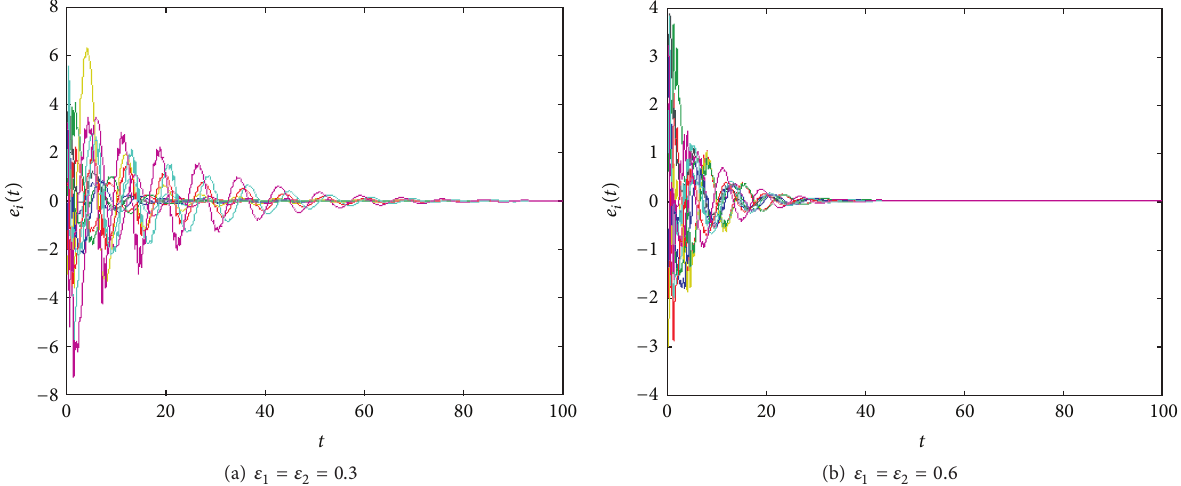
Figure 3: Synchronization errors for the public traffic supernetwork with different value of 𝜀 1 , 𝜀 2 .